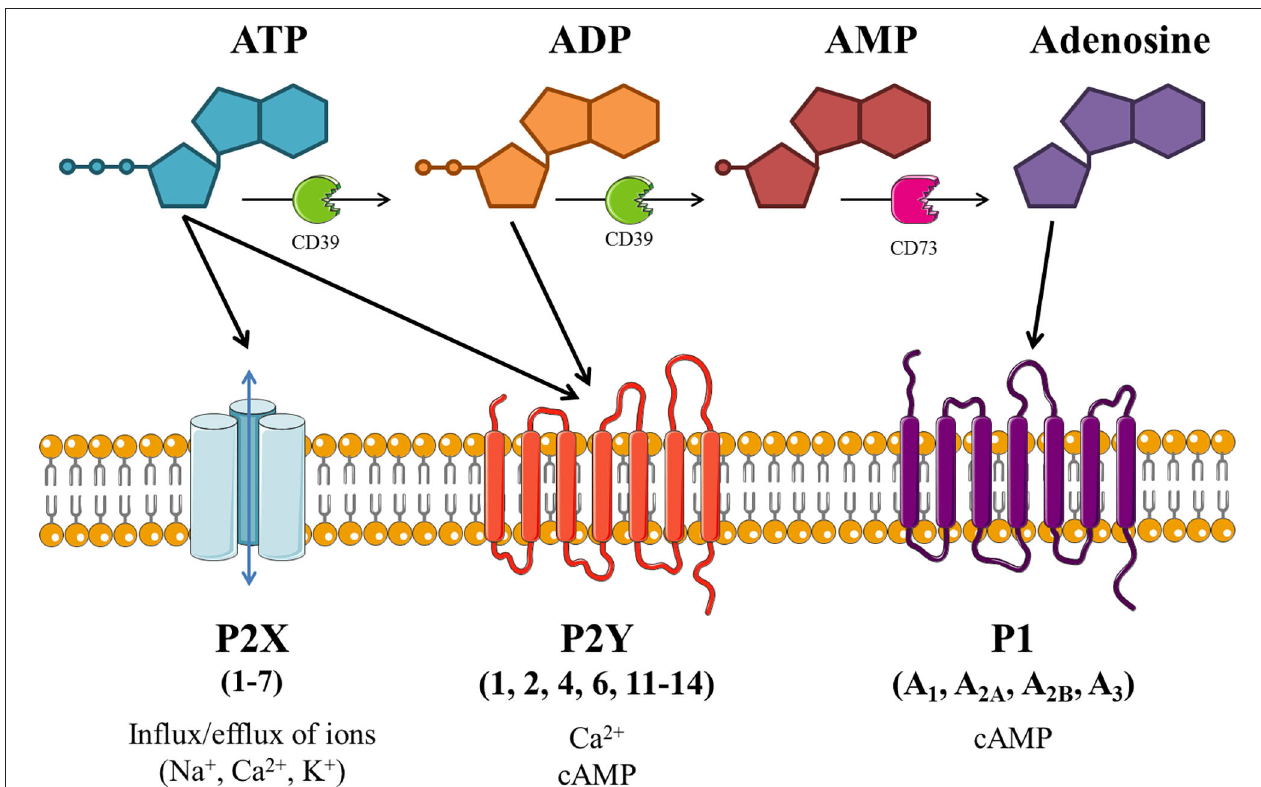
FIGURE 1 | Schematic of purinergic signaling. Extracellular adenosine 5’-triphosphate (ATP) activates P2X and/or P2Y receptors, thus altering intracellular concentrations of ions and/or cyclic adenosine monophosphate (cAMP). ATP can be hydrolyzed by ectonucleotidases (including CD39 and CD73), producing adenosine diphosphate (ADP), adenosine monophosphate (AMP) and adenosine. ADP is also able to activate P2Y receptors, while adenosine activates P1 receptors which modulate adenylate cyclase (AC) activity to alter intracellular cAMP levels. Image is based on Giuliani et al. (18), created with the aid of Servier Medical